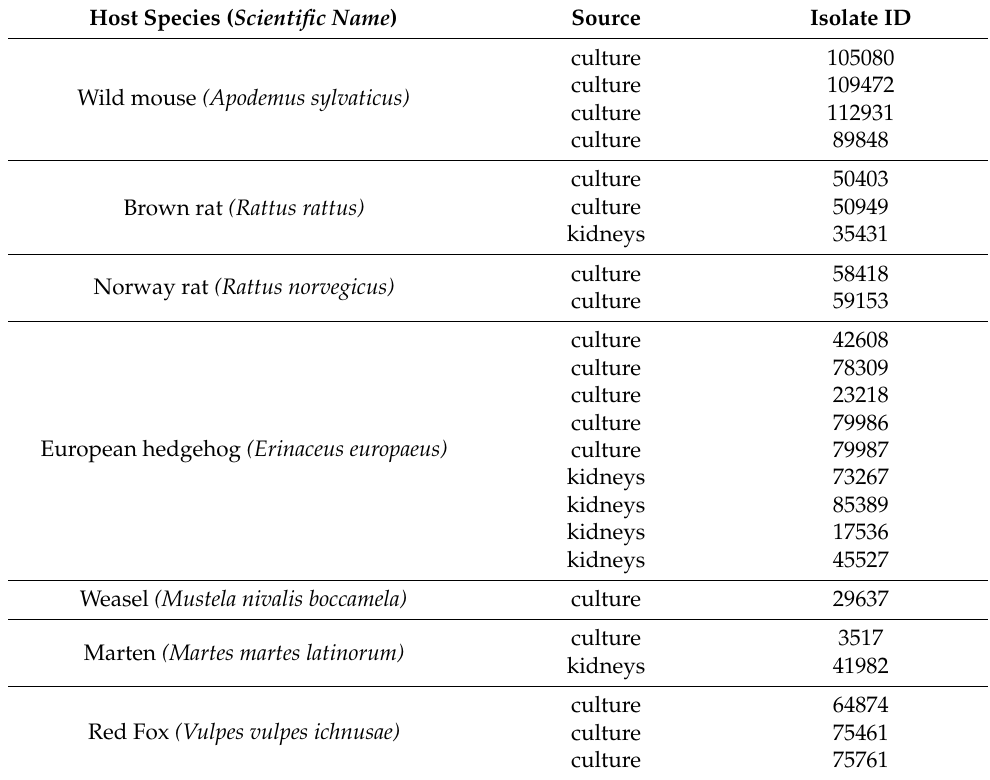
Table 1. Origin of samples investigated in this